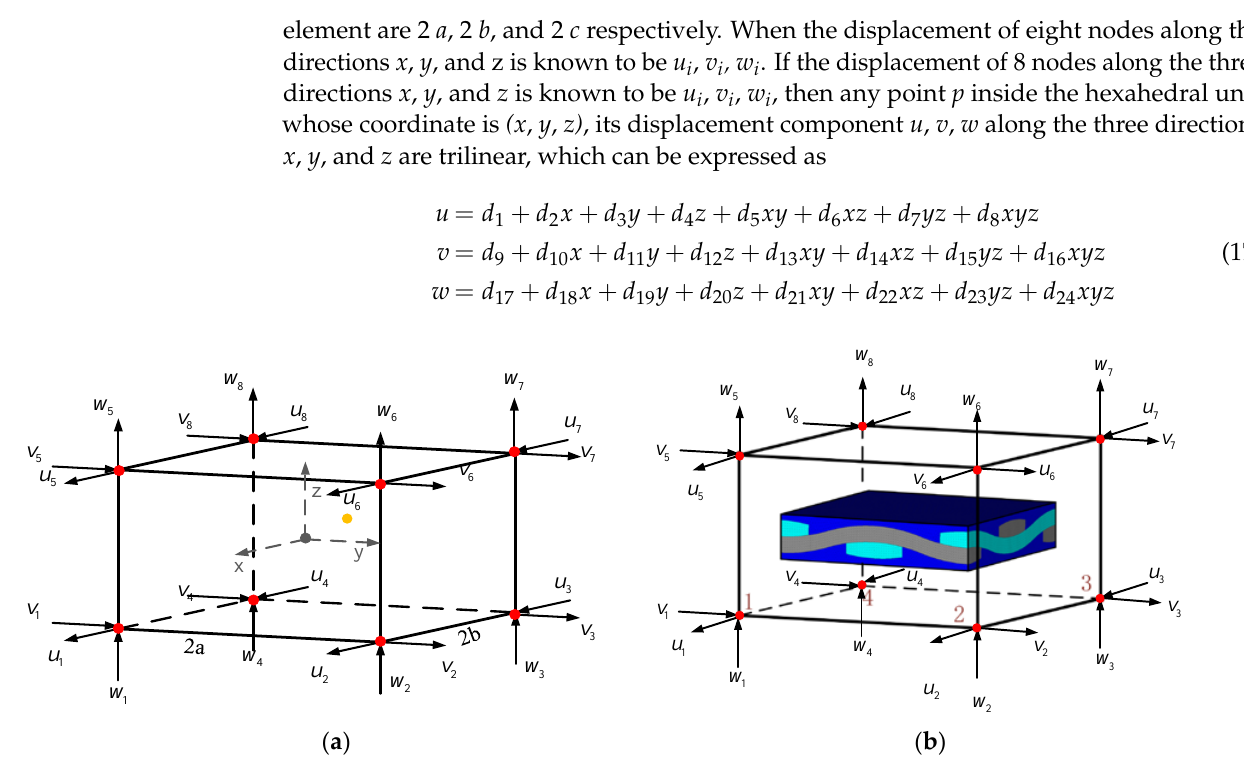
Figure 2. Interpolation based on finite element shape function. ( a ) Eight-node hexahedron element; ( b ) Obtaining the boundary conditions of the meso-scale model.